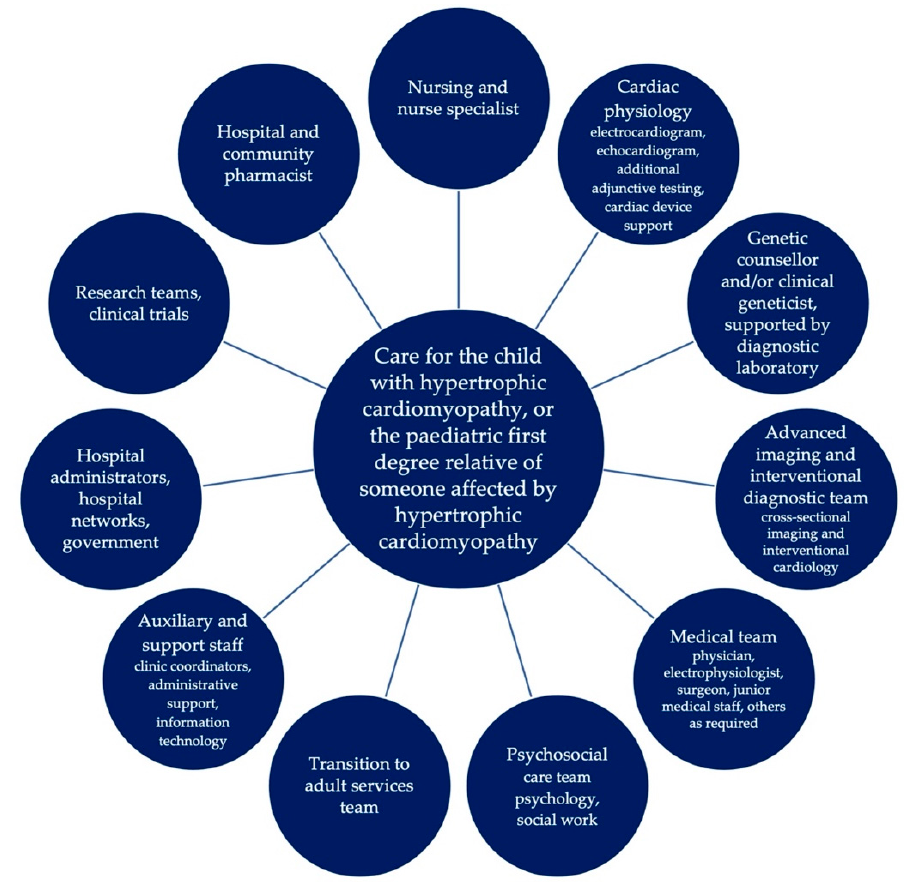
Figure 1. A proposed multidisciplinary approach to caring for the child or adolescent with HCM or a paediatric fi rst-degree relative of someone a ff ected by HCM.